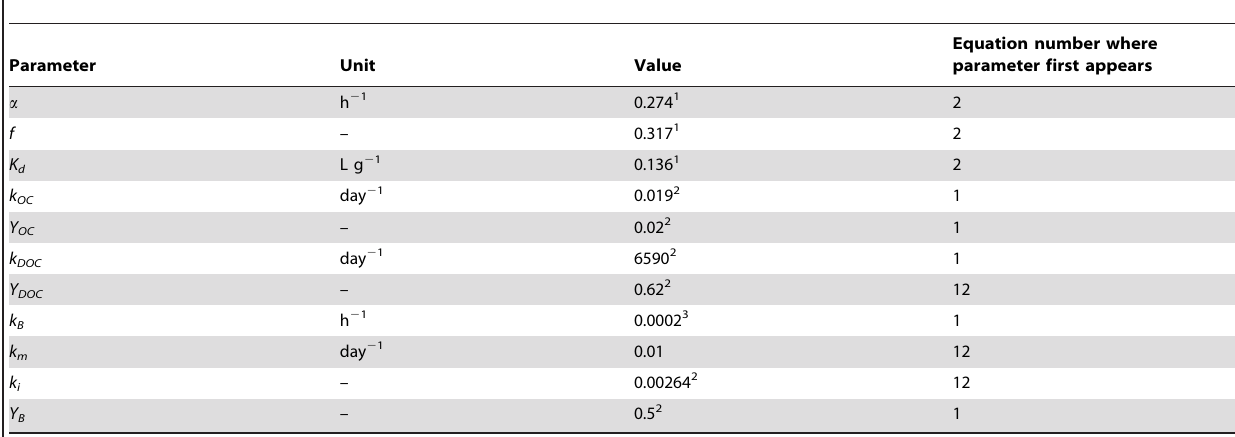
Table 1. Default parameter values used in model simulations.